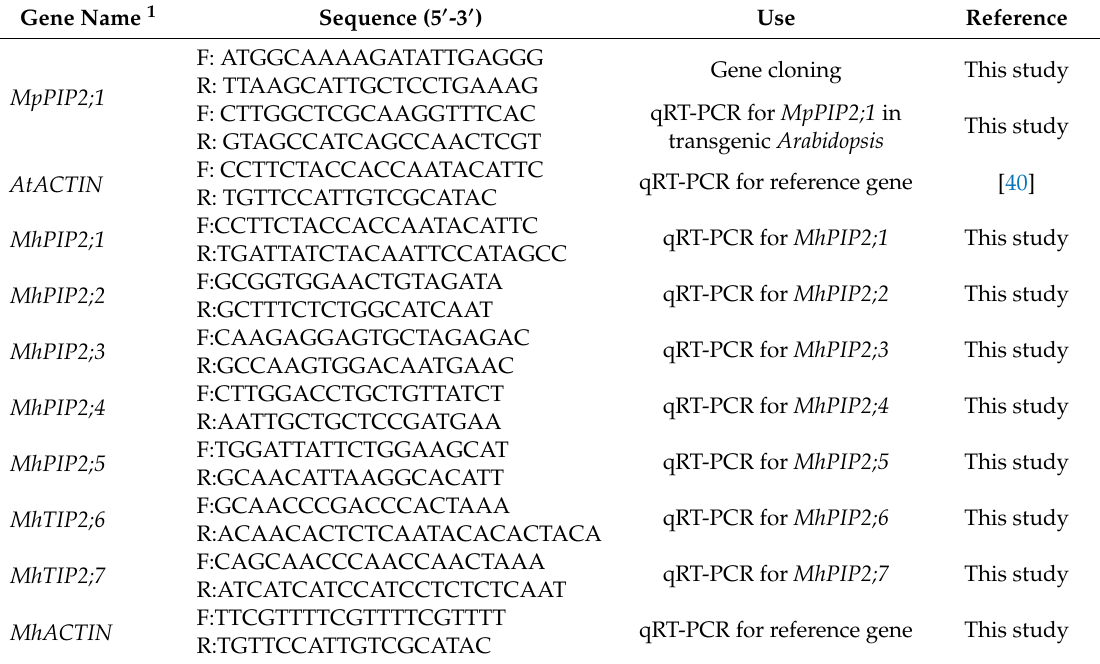
Table 3. Primers used in this